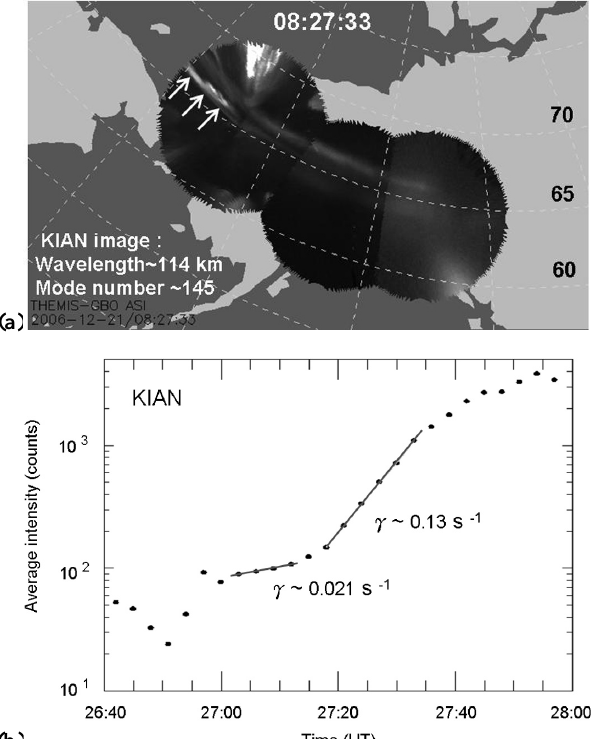
Fig. 4. (a) Auroral arc form observed by the THEMIS ASIs located at KIAN, GAKO, and WHIT for the 21 December 2006 substorm event, and (b) the temporal evolution of the average arc